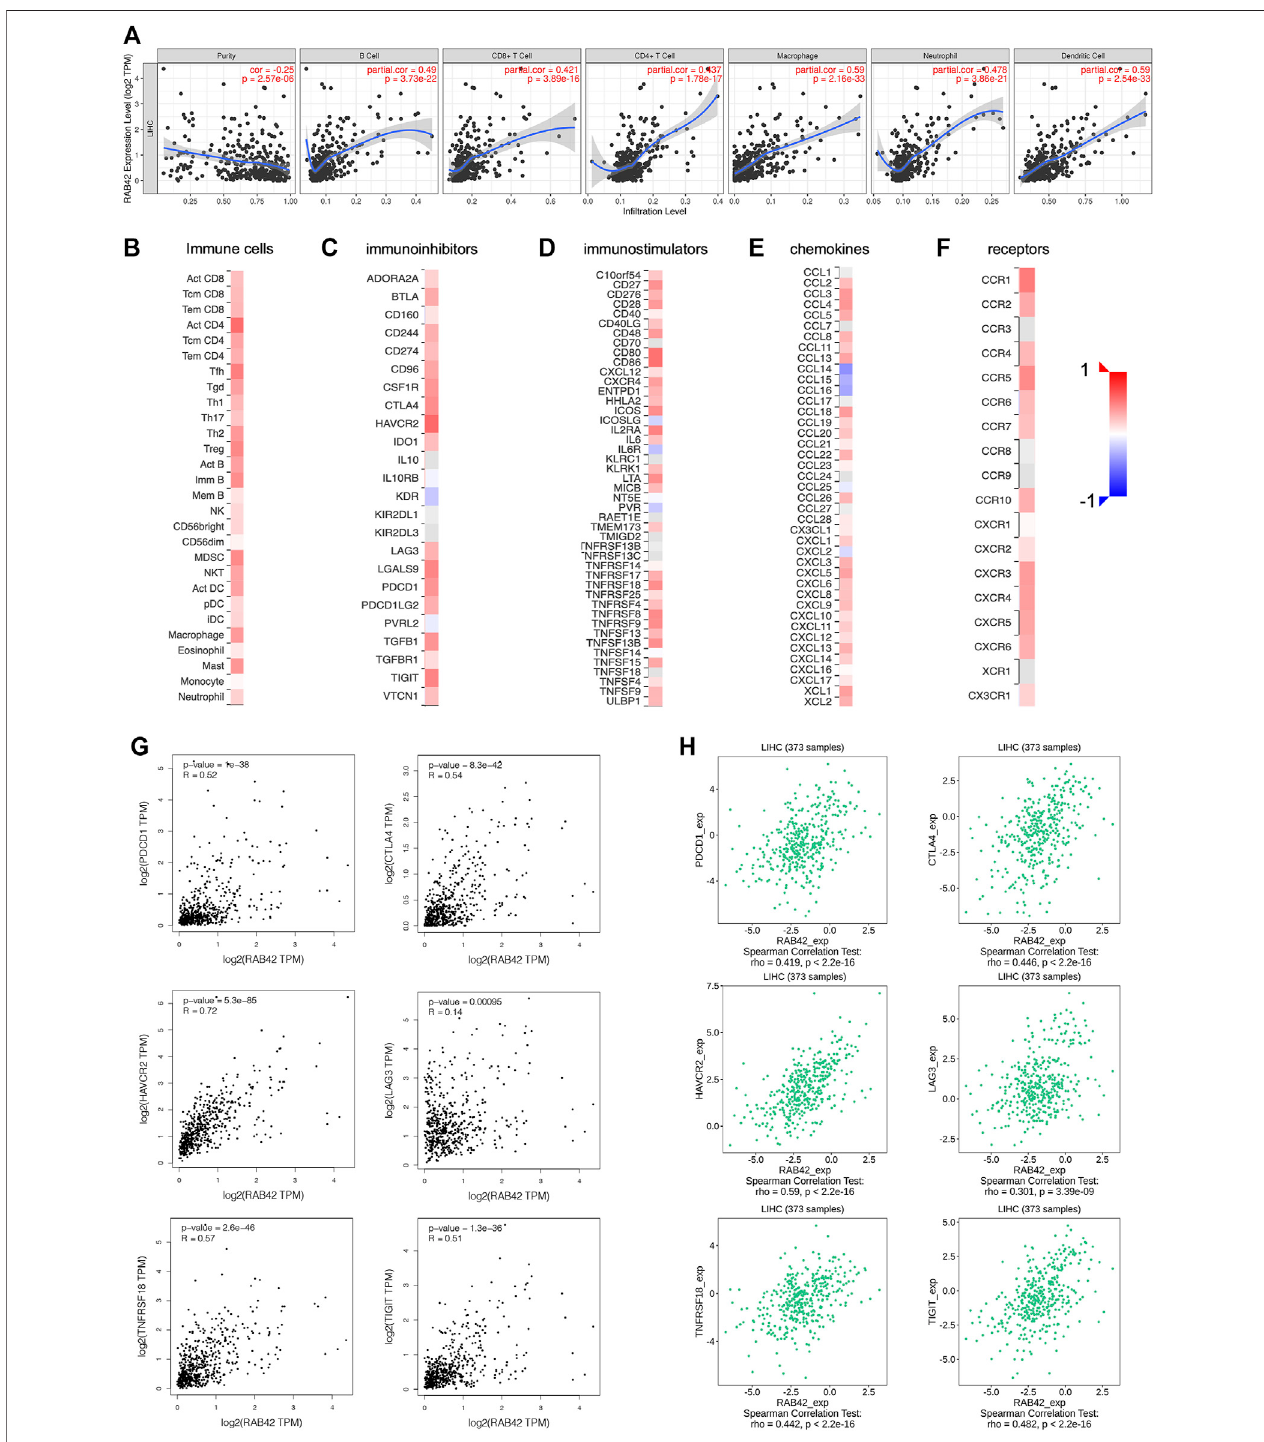
FIGURE 7 | Relationship between RAB42 expression and immune cells in fi ltration in HCC. (A) Correlation analysis based on TIMER database showed RAB42 expression was positively correlated with tumor in fi ltrating lymphocytes in HCC tissues, including B cells, CD8 + T cells, CD4 + T cells, macrophages, neutrophils, and dendritic cells. Heat map showed the correlation between the RAB42 expression and various types of immune cells (B) , immunoinhibitors (C) , immunostimulators (D) , chemokines (E) , receptors (F) in HCC from the TISIDB database. The GEPIA database (G) and the TISIDB database (H) were used to evaluate the relationship between RAB42 expression and major immune checkpoint molecules in HCC, including PDCD1, CTLA-4, HAVCR2, LAG3, TNFRSF18 and TIGIT.